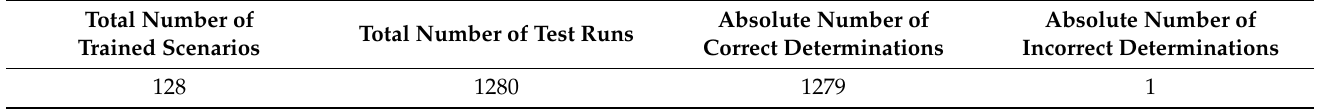
Absolute Number of Absolute Number of Correct Determinations Incorrect Determinations